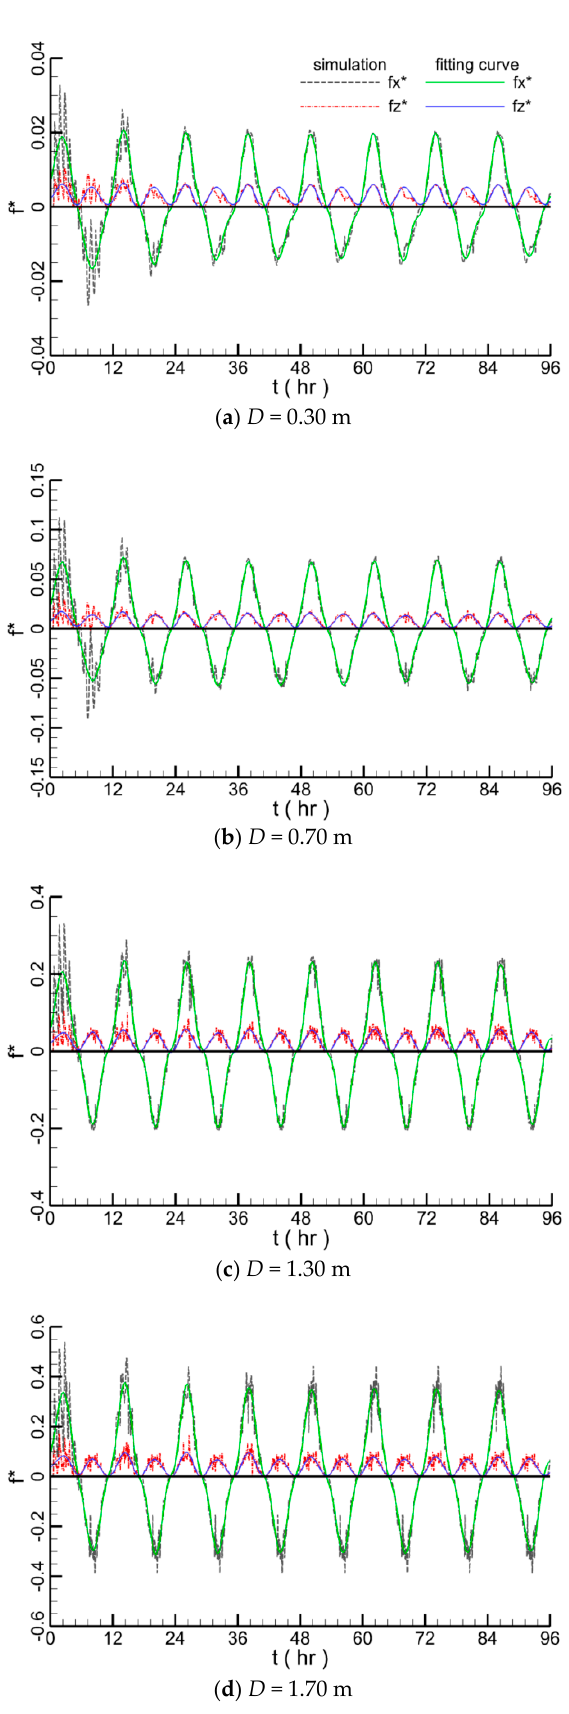
Figure 14. The hydrodynamic forces on the pipeline with different pipeline diameters.